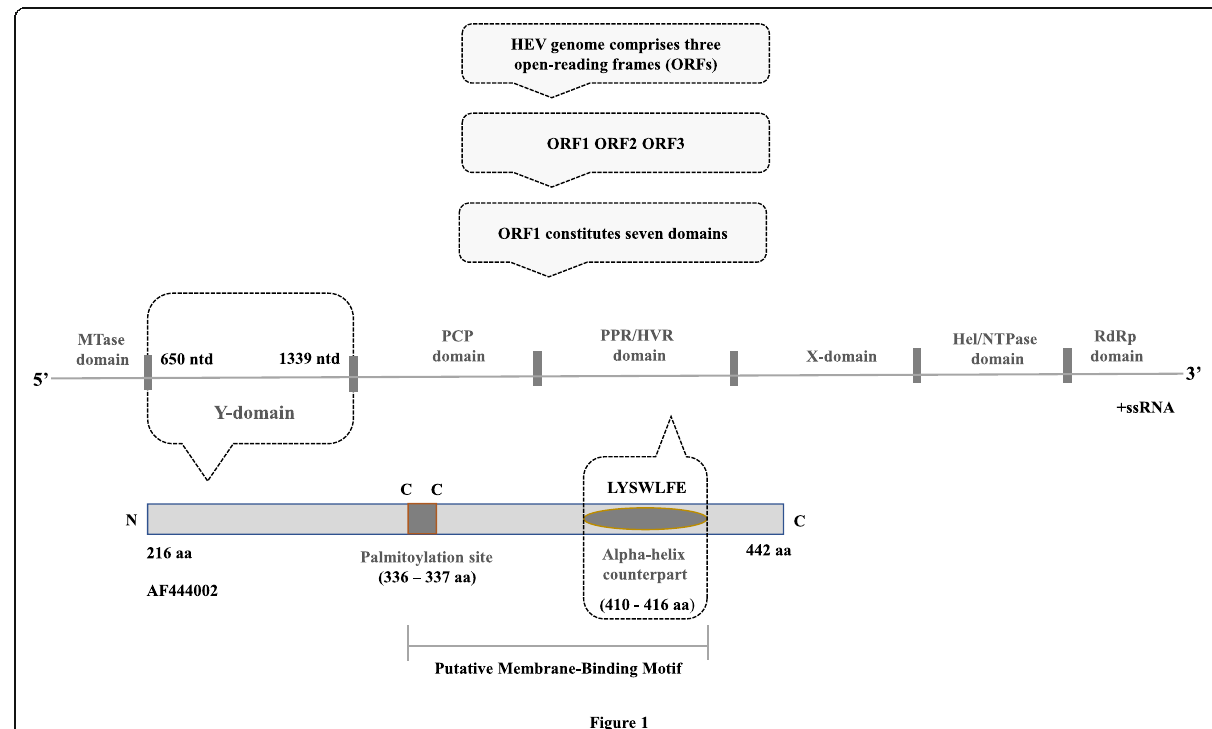
Fig. 1 Diagrammatic representation of hepatitis E virus nonstructural polyprotein (ORF1) domain, showing the Y-domain. The ORF1 constitutes seven domains, i.e., MTase, methyltransferase; Y, undefined; PCP, papain-like cysteine protease; P/HVR, proline-rich/hypervariable region; X, Macro; Hel/NTPase, helicase/nucleotide triphosphatase; and RdRp, RNA-dependent RNA polymerase. The Y-domain region (YDR) is of 228 amino acids in length (650 – 1339 nucleotides) and consists of a potential palmitoylation site (C 336 C 337 ) and an alpha-helix segment (L 410 Y 411 S 412 W 413 L 414 F 415 E 416 ). These segments are found to be indispensable for cytoplasmic membrane binding and are highly conserved within HEV